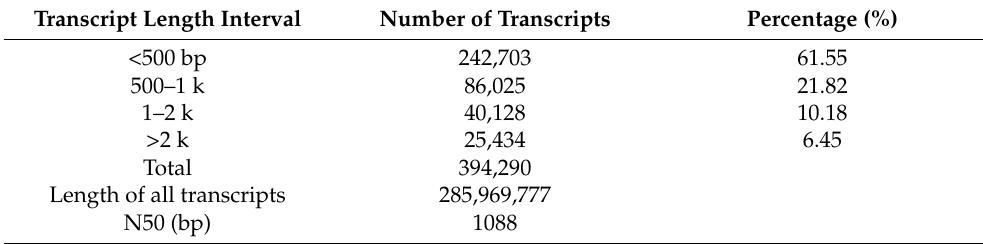
Table 1. Length distribution of R. chinensis